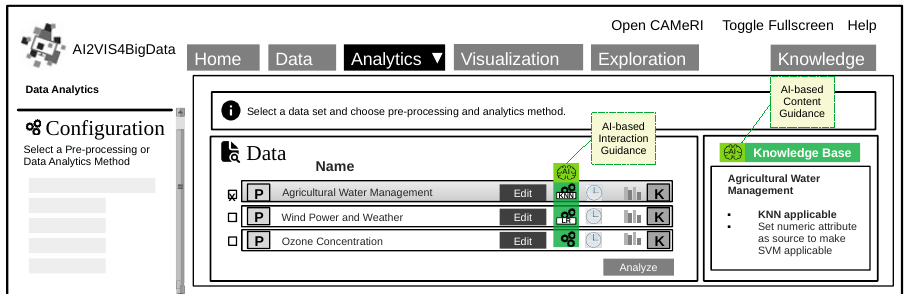
Figure 12. Integration of extracted data insights into the AI2VIS4BigData UI concept